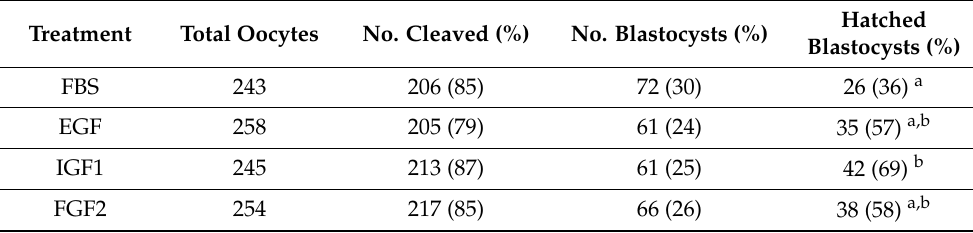
Table 3. Effect of EGF, IGF1 and FGF2 in defined KSOM embryo culture medium on the in vitro embryonic development of bovine embryos.